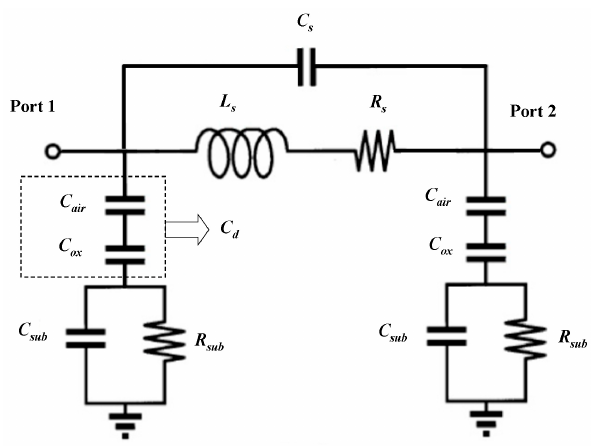
Figure 1. The π model of the micro-electromechanical system (MEMS) suspended inductor.